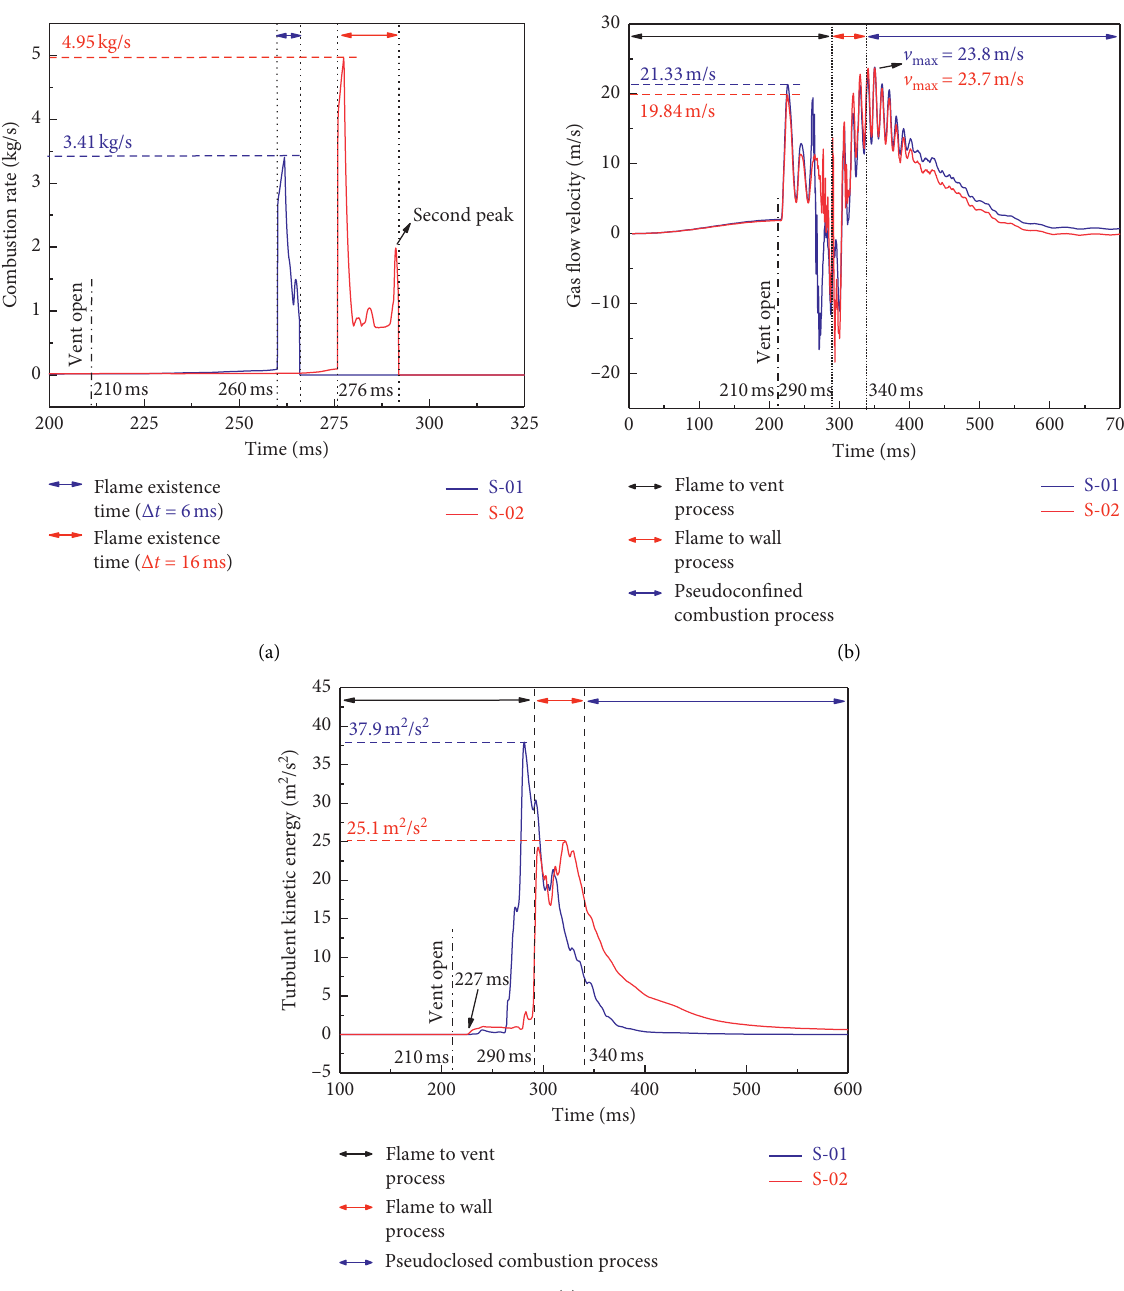
Figure 13: Time curve of flow-field parameter change in the vicinity of range hood. (a) Combustion rate. (b) Gas flow velocity. (c) Turbulent kinetic